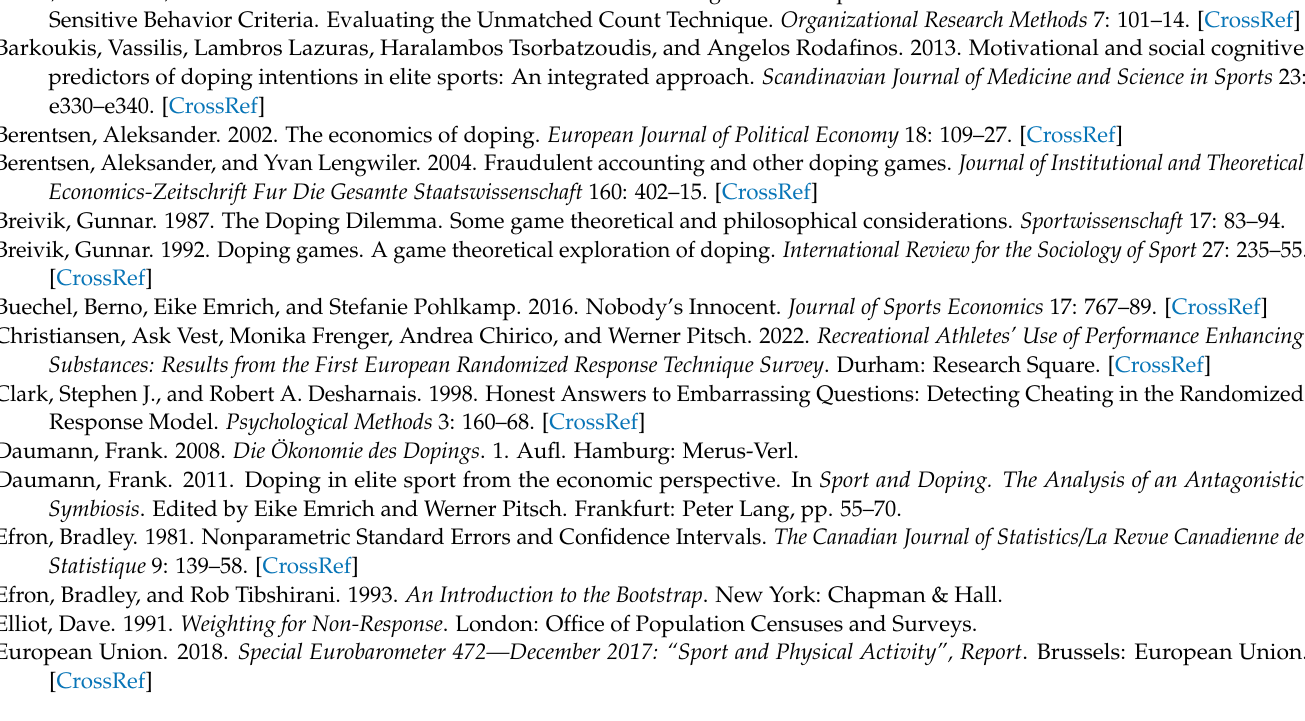
a sport. Table S3: Bootstrapped CI’s for competing and non-competing